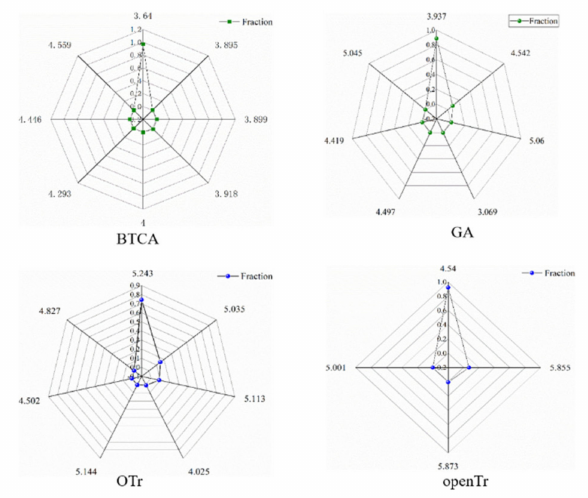
Figure 9. Fan-shaped distribution of effective cross-linking distance.